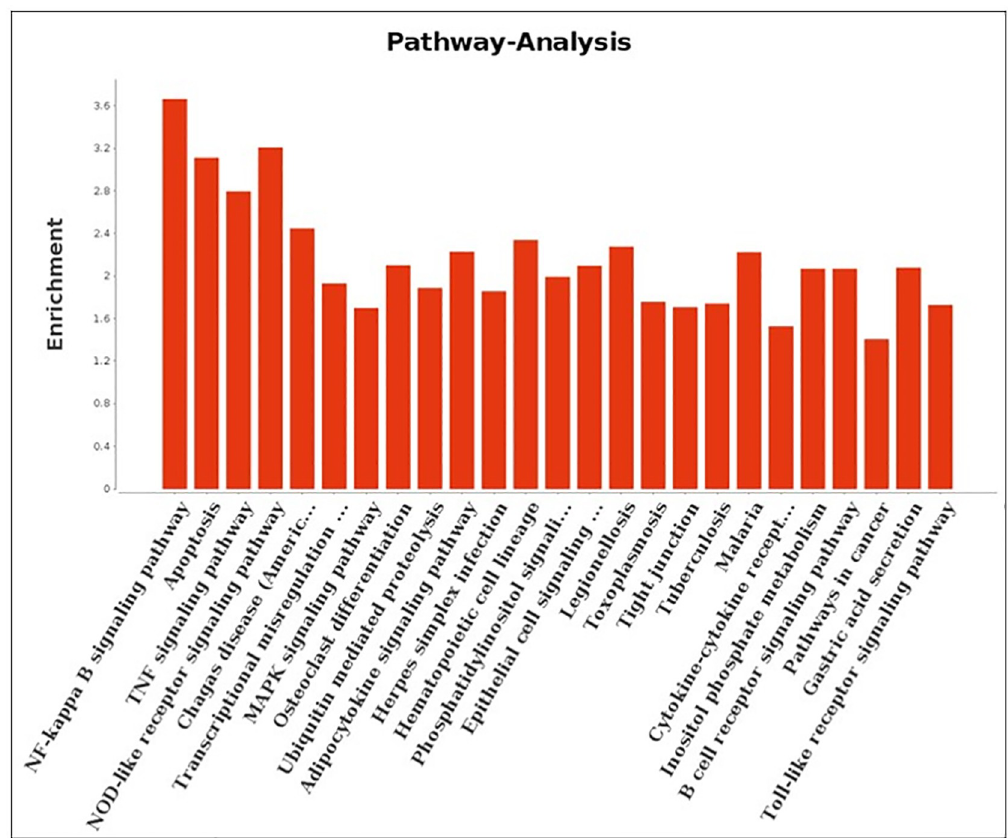
Fig 4. Pathway analysis of differentially expressed genes according to the KEGG database. Top-ranking regulated pathways identified by KEGG according to P-value < 0.01 and FDR < 0.01.